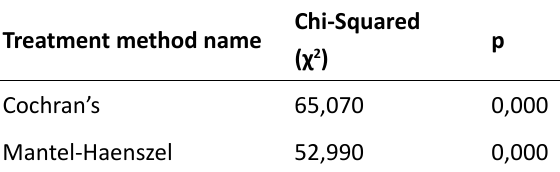
Table 3. Influence of the level of technique on the number of students’ injuries during rock climbing lessons